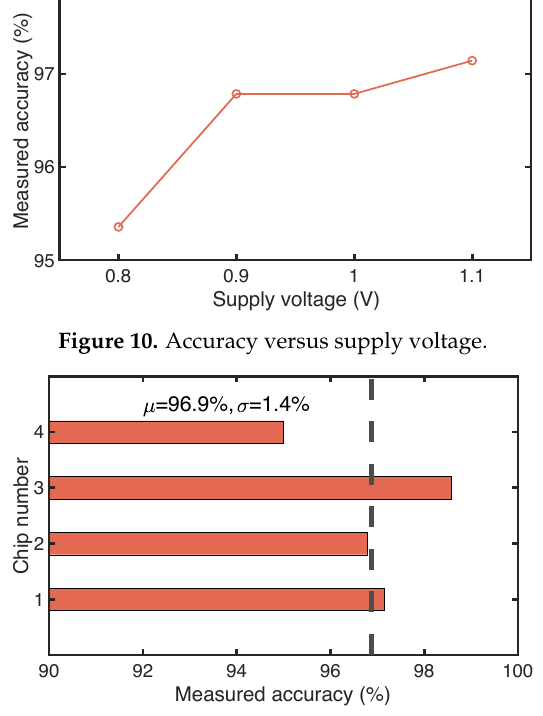
Figure 11. Accuracy variation across multiple chips.